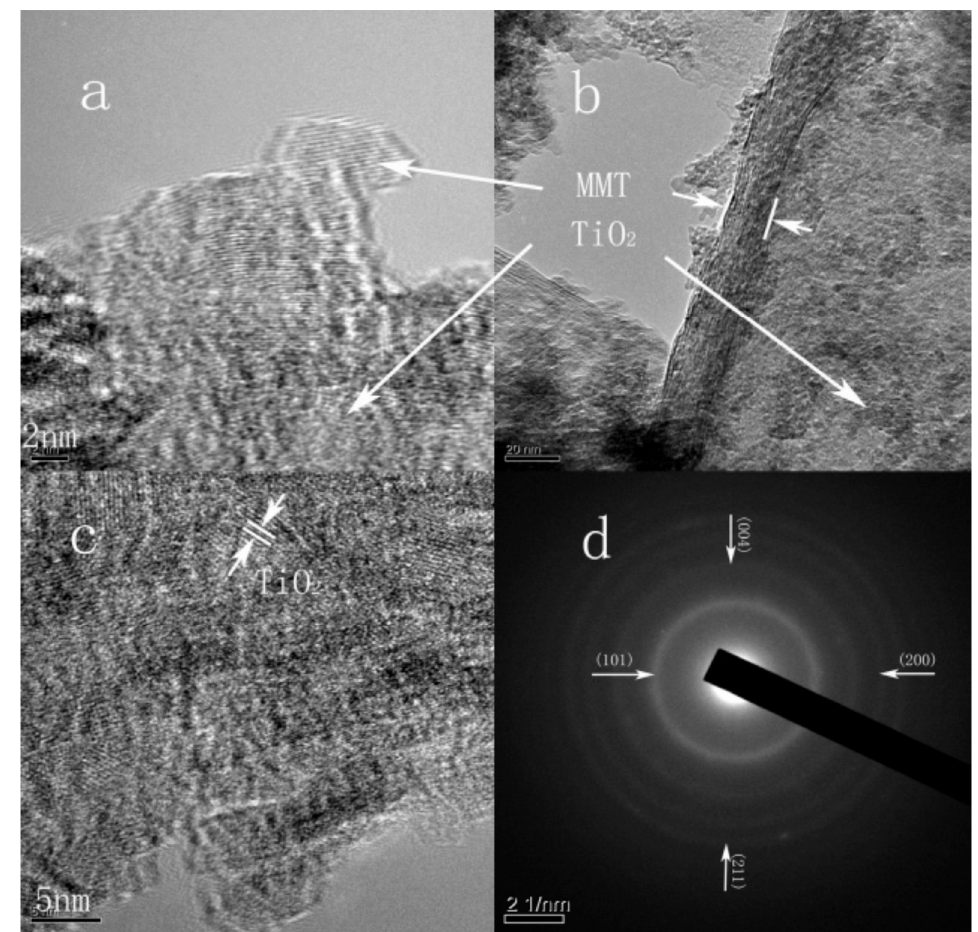
Figure 11. ( a – c ) TEM images of TiO 2 pillared montmorillonite, ( d ) SAED pattern of TiO 2 nanoparticle. Adapted with permission from ref. [165]. Copyright 2008 American Chemical Society.